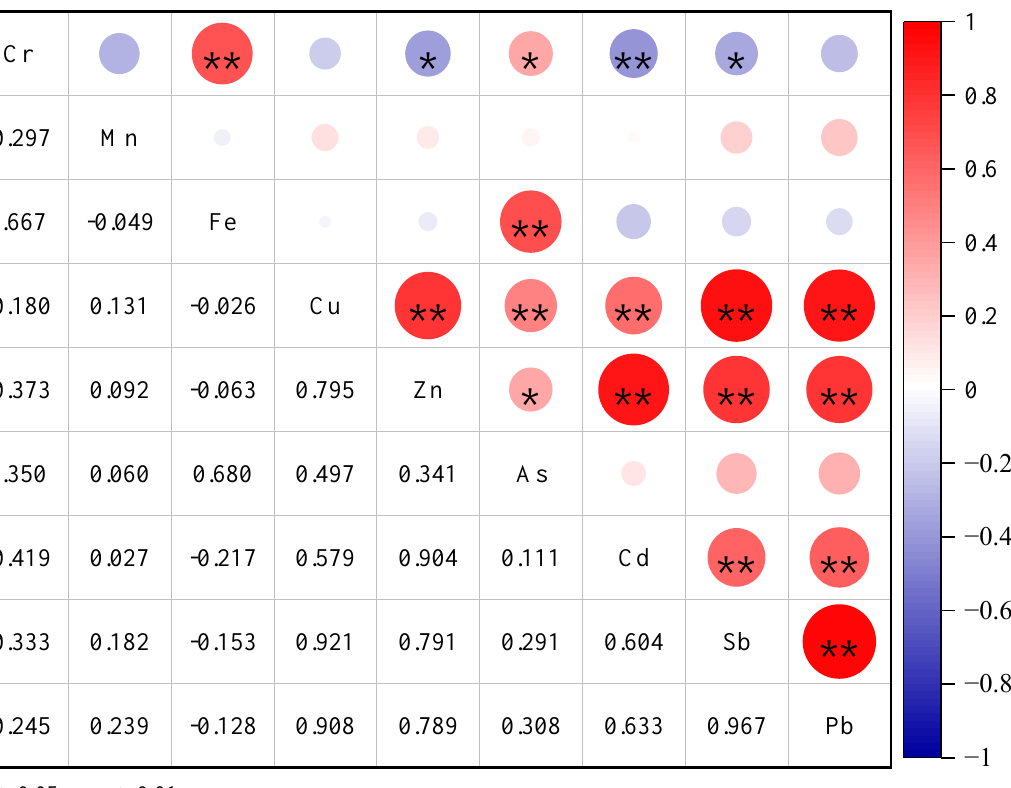
Figure 10. Correlation coefficient of HMs. (Note: indicates a significant correlation at the 0.01 level (bilateral); indicates significant correlation at the 0.05 level (bilateral); sample size n = 40). PCA can reduce the number of influencing factors and assign weights to each factor in order to determine the sources of HMs in soil [34]. The results are presented in Table 3.